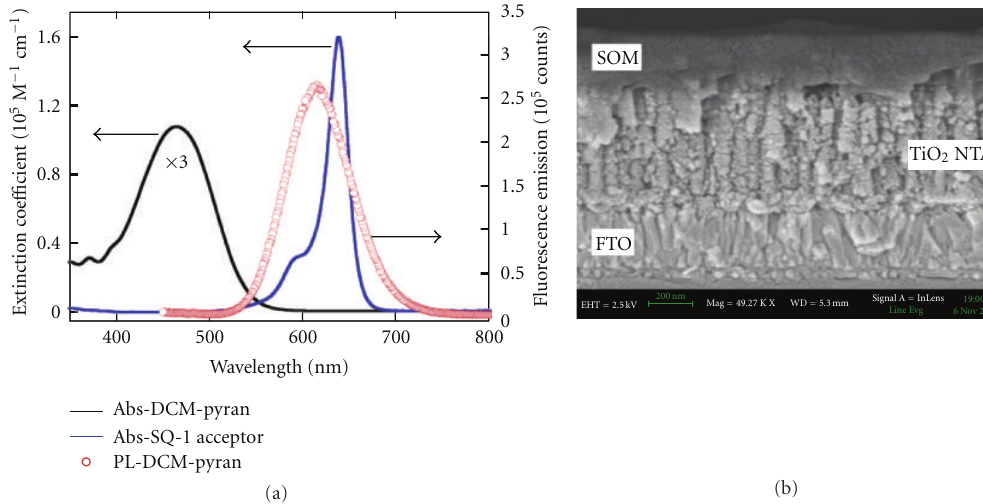
Figure 15: (a) Extinction coe ffi cient of DCM-pyran donor and SQ-1 acceptor molecules dissolved in ethanol/acetonitrile-solvent mixture and the emission spectra of the same DCM-pyran solution. The DCM-pyran extinction coe ffi cient is multiplied by 3 for display purposes. (b) Cross-sectional FE-SEM image showing DCM-Spiro-OMeTAD (denoted SOM) infiltration within SQ-1 dye-sensitized TiO 2 nanotube array (NTA, nanotube pore size ∼ 20 to 28 nm, length ≈ 500 to 600nm). FTO denotes the fluorine-doped tin oxide layer upon the glass substrate. Reprinted with permission from